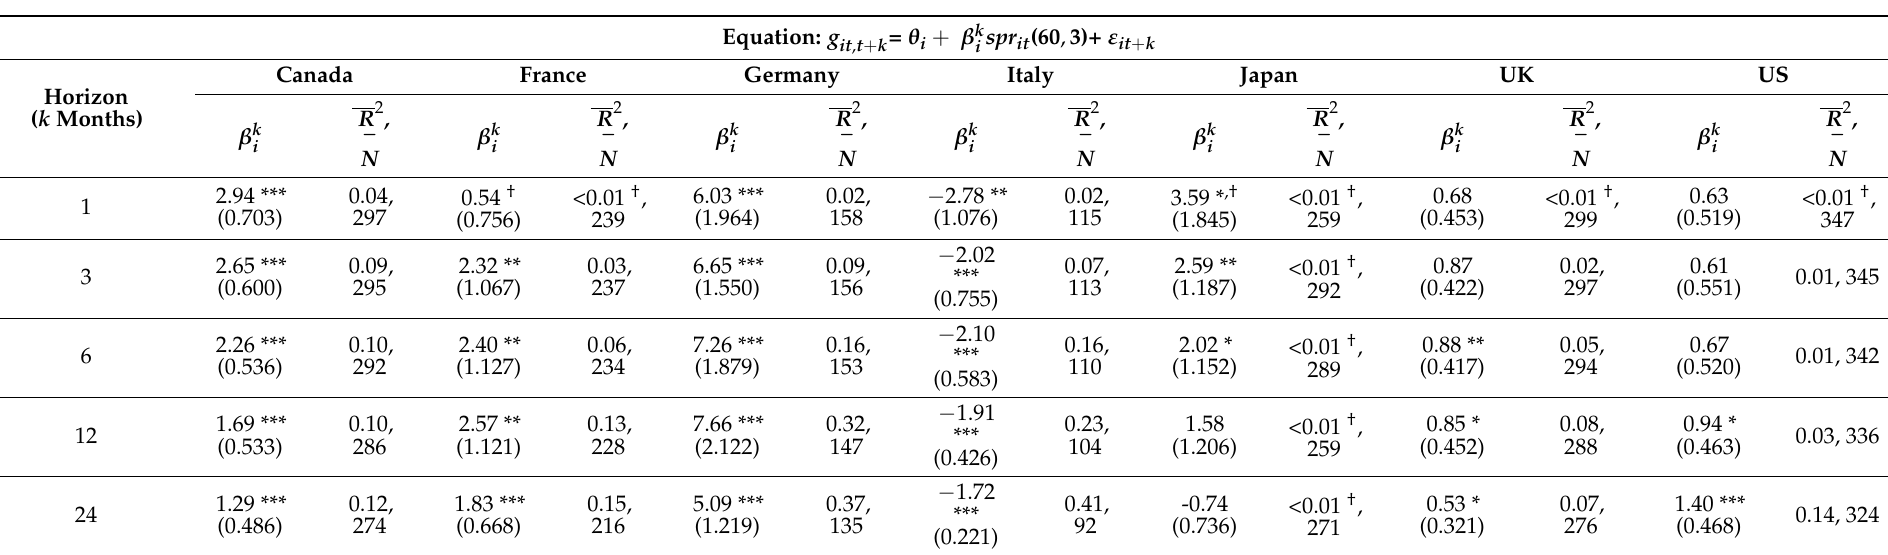
Table A1. Economic activity and the term spread—cumulative